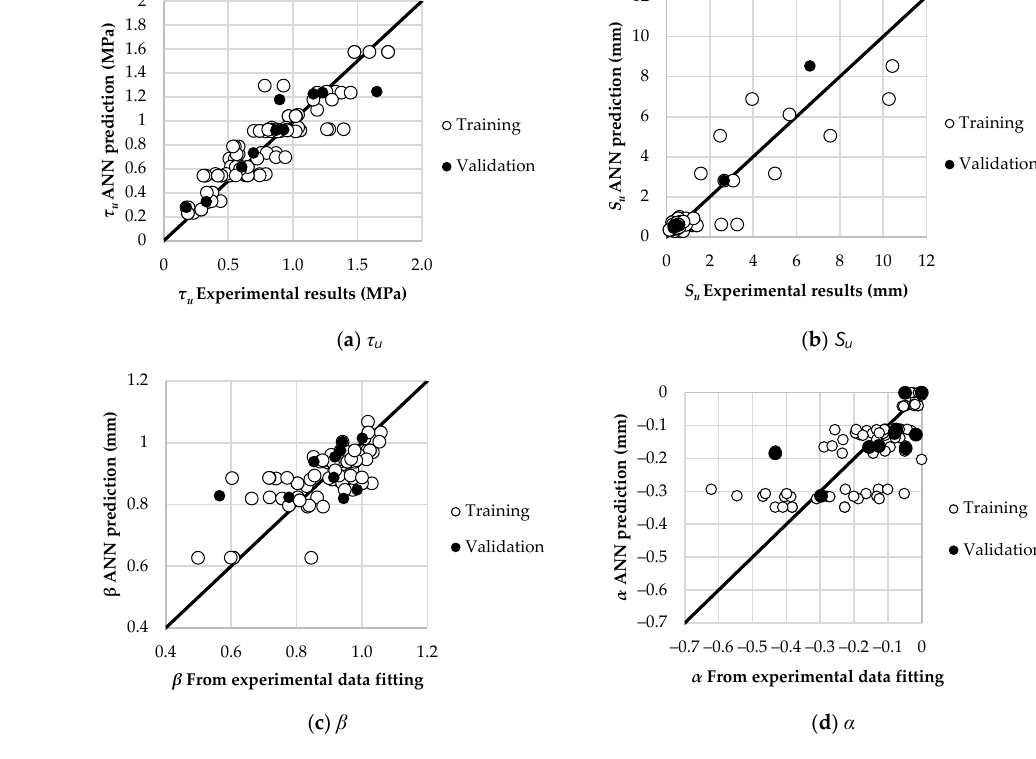
Figure 7. Comparison and discussion of results.